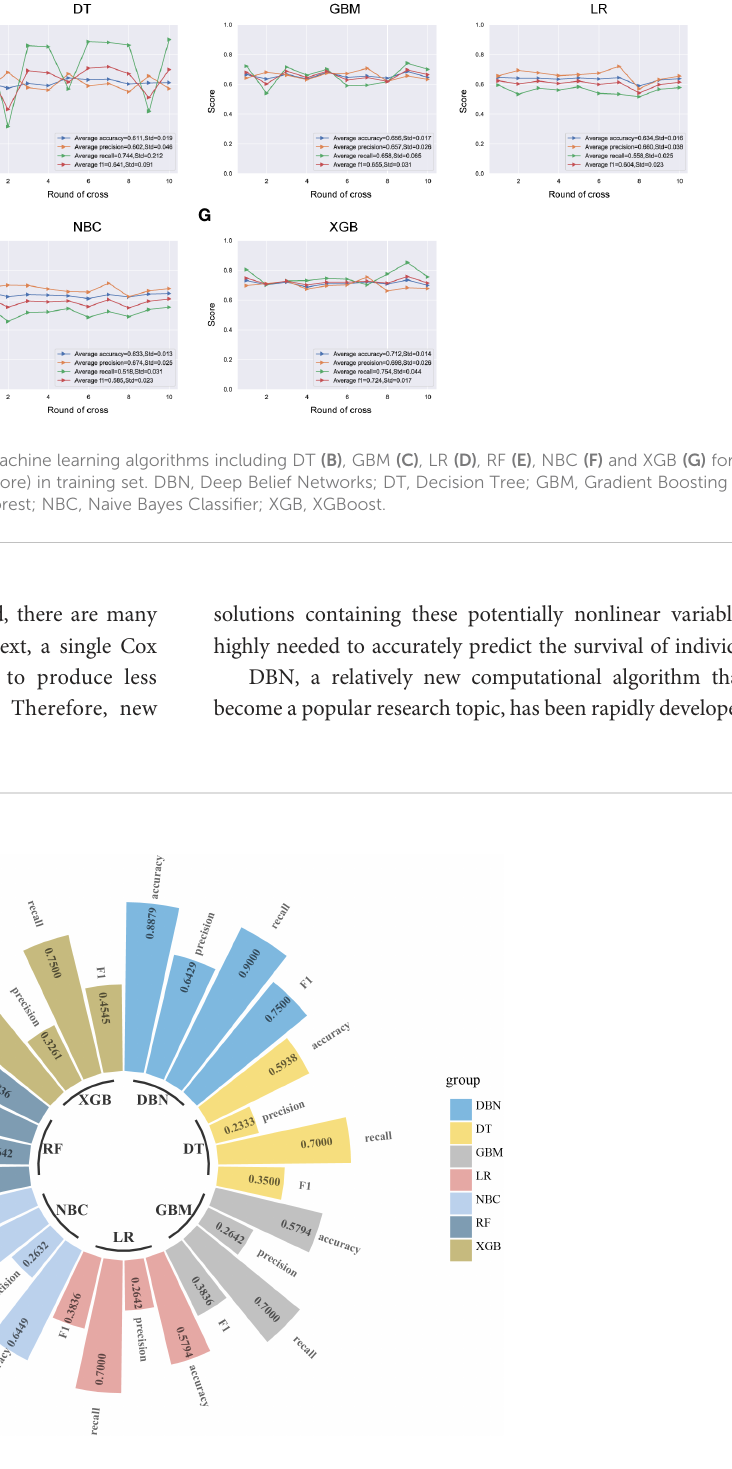
FIGURE 3 Comparison of DBN algorithm and other 6 machine learning algorithms including DT, GBM, LR, RF, NBC and XGB for accuracy, precision, recall, and F-measure (F1-Score) in validation set. DBN, Deep Belief Networks; DT, Decision Tree; GBM, Gradient Boosting Machine; LR, Logistic Regression; RF, Random Forest; NBC, Naive Bayes Classi fi er; XGB, XGBoost.